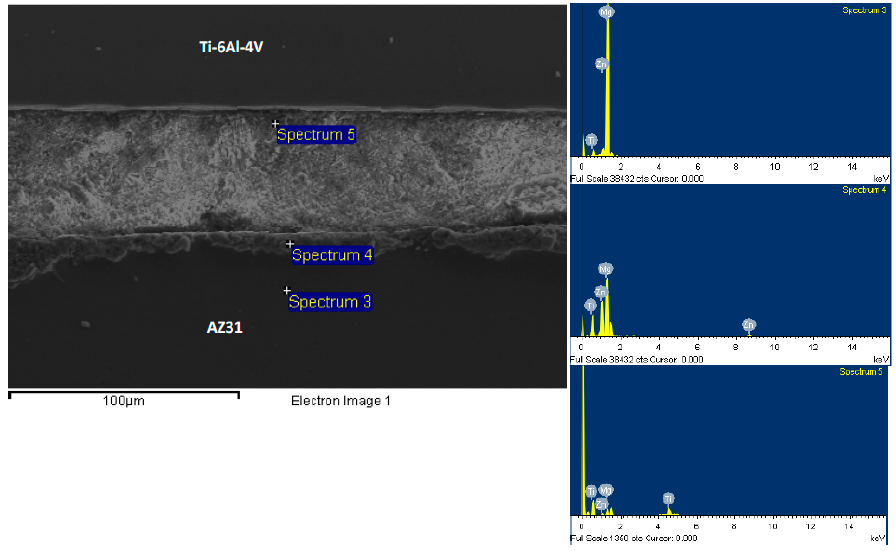
Figure 5. SEM micrograph of the bond made at 5 min and corresponding EDS spot analysis.